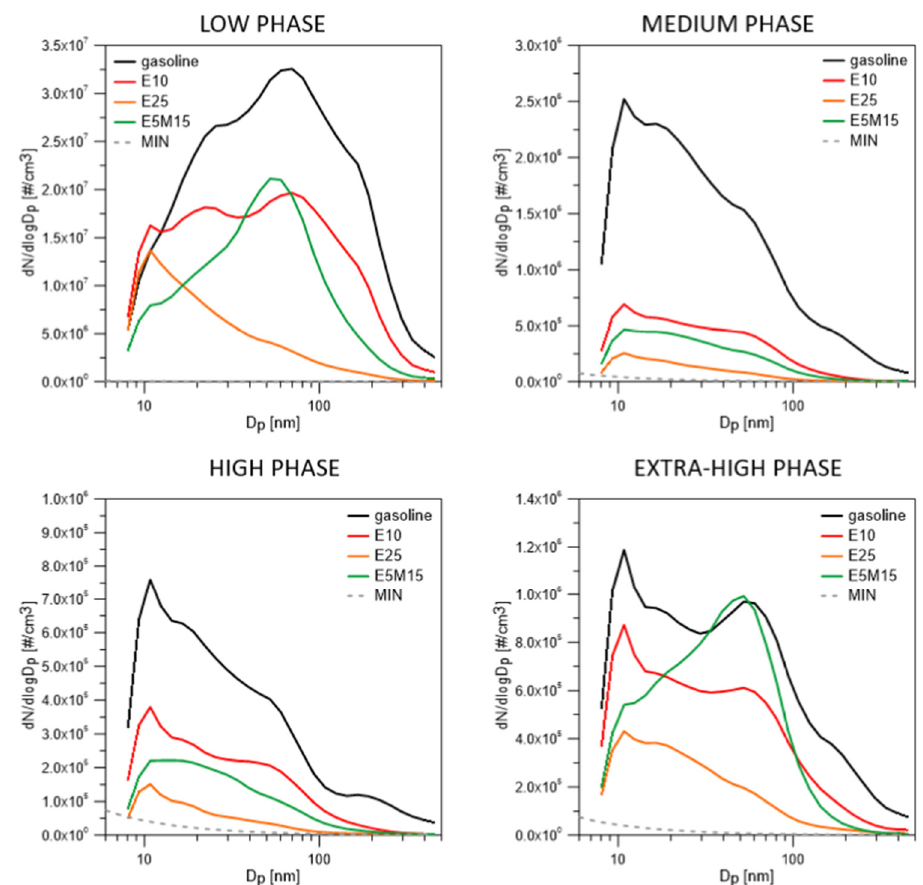
Figure 9. Mean PSDFs at low, medium, high and extra-high phases of the WLTC for gasoline, E10, E25 and E5M15.